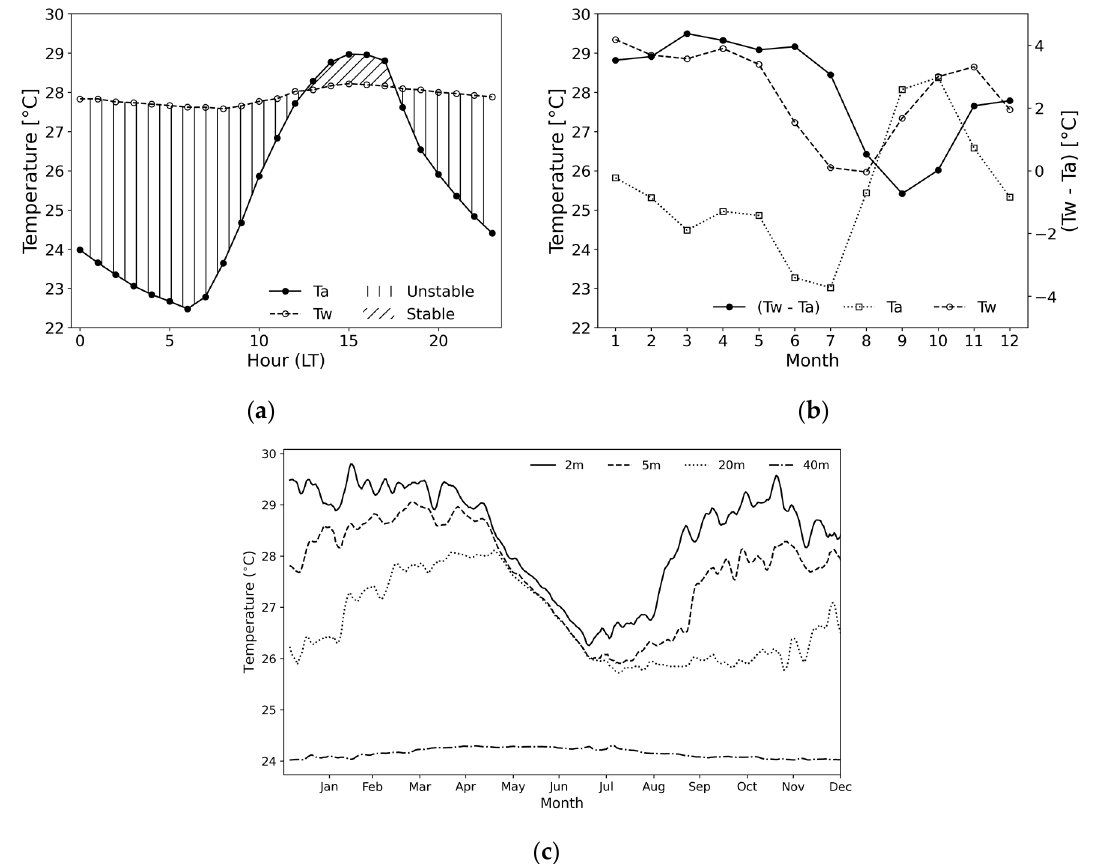
Figure 4. ( a ) Diurnal and ( b ) seasonal cycle for the air temperature (Ta) and water surface temperature (Tw) in Serra da Mesa reservoir. ( c ) Seasonal cycle of water temperature for various depths of the reservoir. Unstable and stable periods shown in the diurnal cycle: ( a ) refers to thermal stratification estimate of the bottom layer (2-m thick) of air over the water surface.